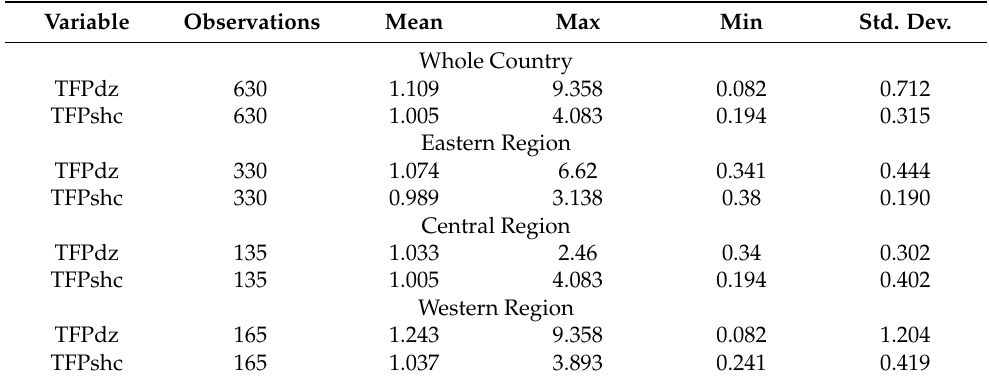
Table 2. The descriptive statistical analysis of the panel data.